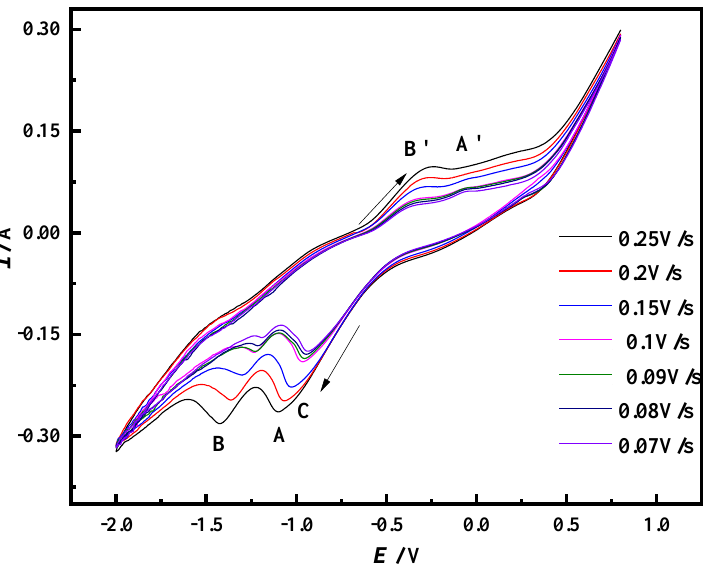
Figure 10. CV diagram of Mo-hole electrode in NaCl-CaCl 2 molten salt system after filling LiNiO 2 (scanning speed: 0.07–0.25 V/s, T = 750 °C, reference electrode: Pt electrode). LiNiO 2 belongs to an ionic lattice structure, and the ions on each node in the powder crystal vibrate around their respective equilibrium positions. At 750 °C, as the applied potential increases, the ion vibration that obtains energy increases. When the potential reaches a certain condition, O 2− obtains the activation energy required for displacement,